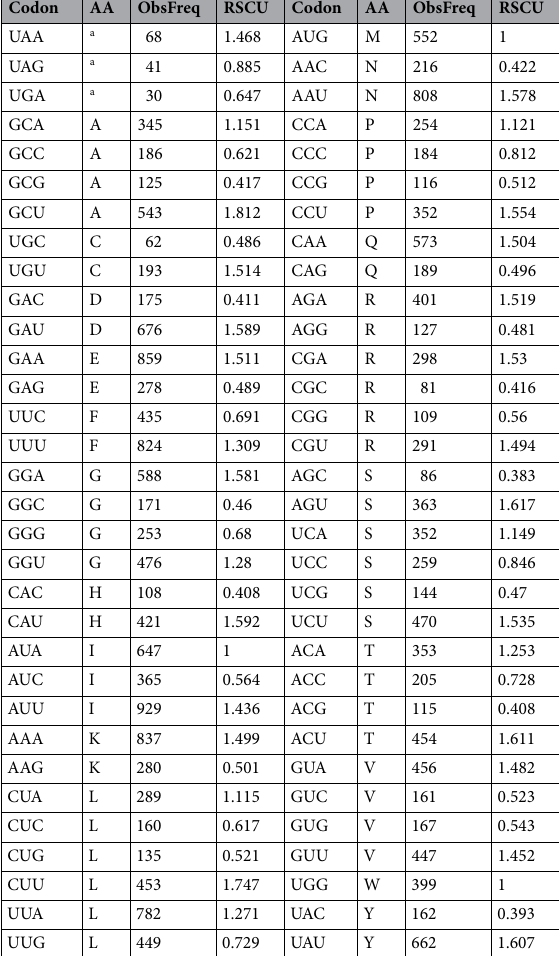
Table 3. The Relative synonymous codon usage (RSCU) of L. ledebourii protein-coding genes. a Stop